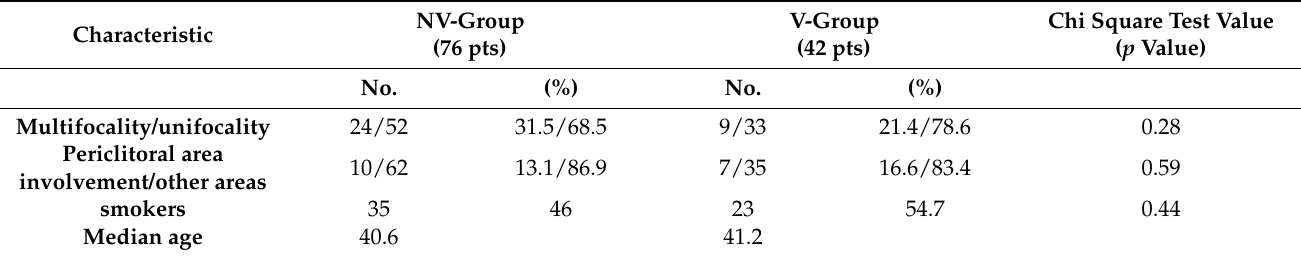
Table 1. Distribution of study subjects according to selected characteristics and treatment group.